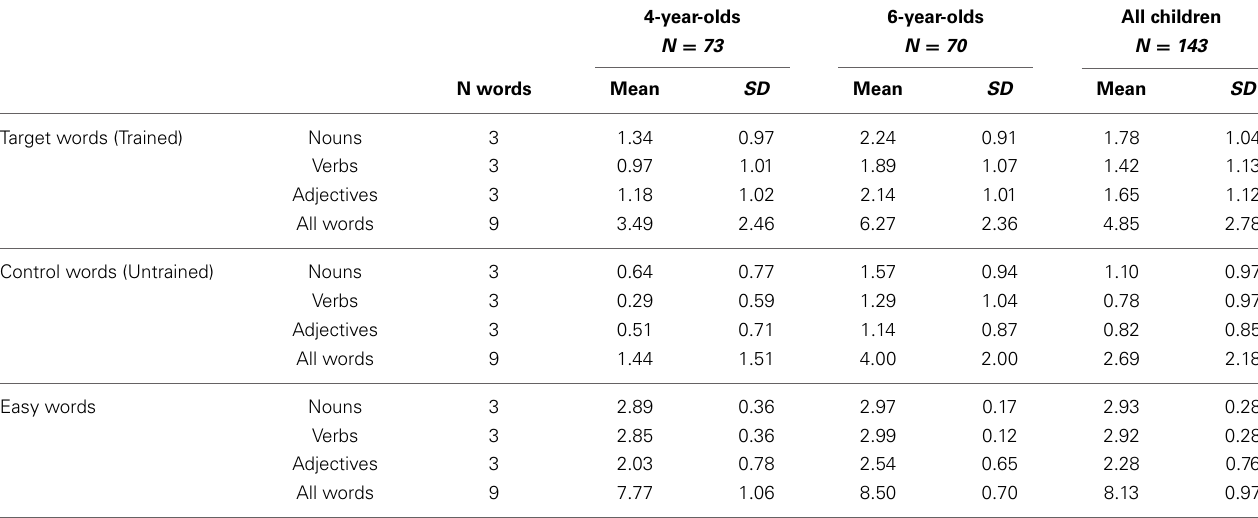
Table 2 | Mean number of appropriate definitions provided for each set of words in the definition production